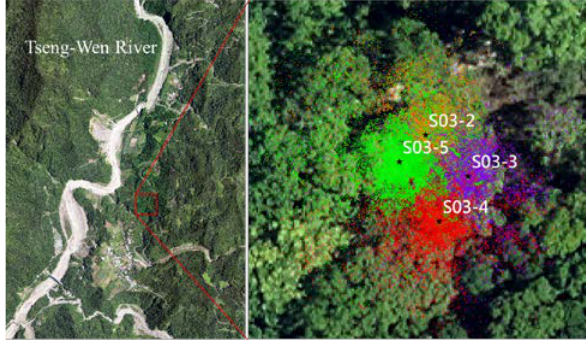
Figure 1. (a) The location map of the study area in Tseng-Wen River. (b) Each colour denotes different TLS